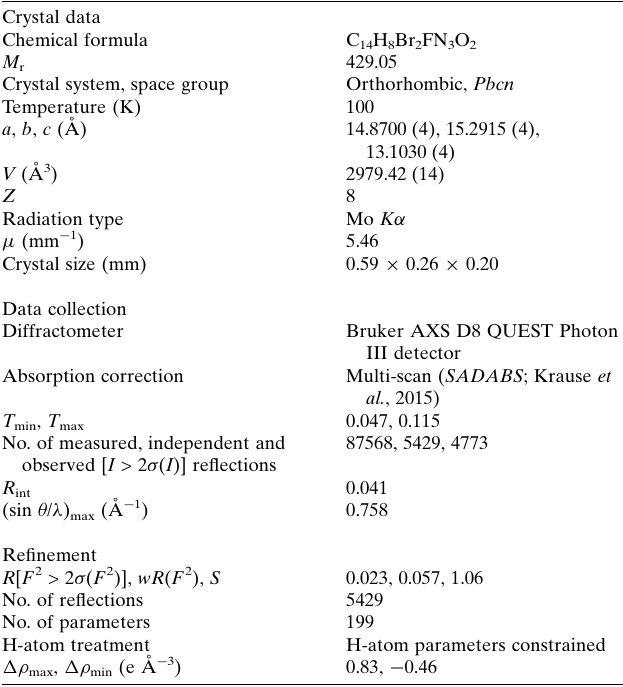
Table 4 Experimental details. Crystal data Chemical